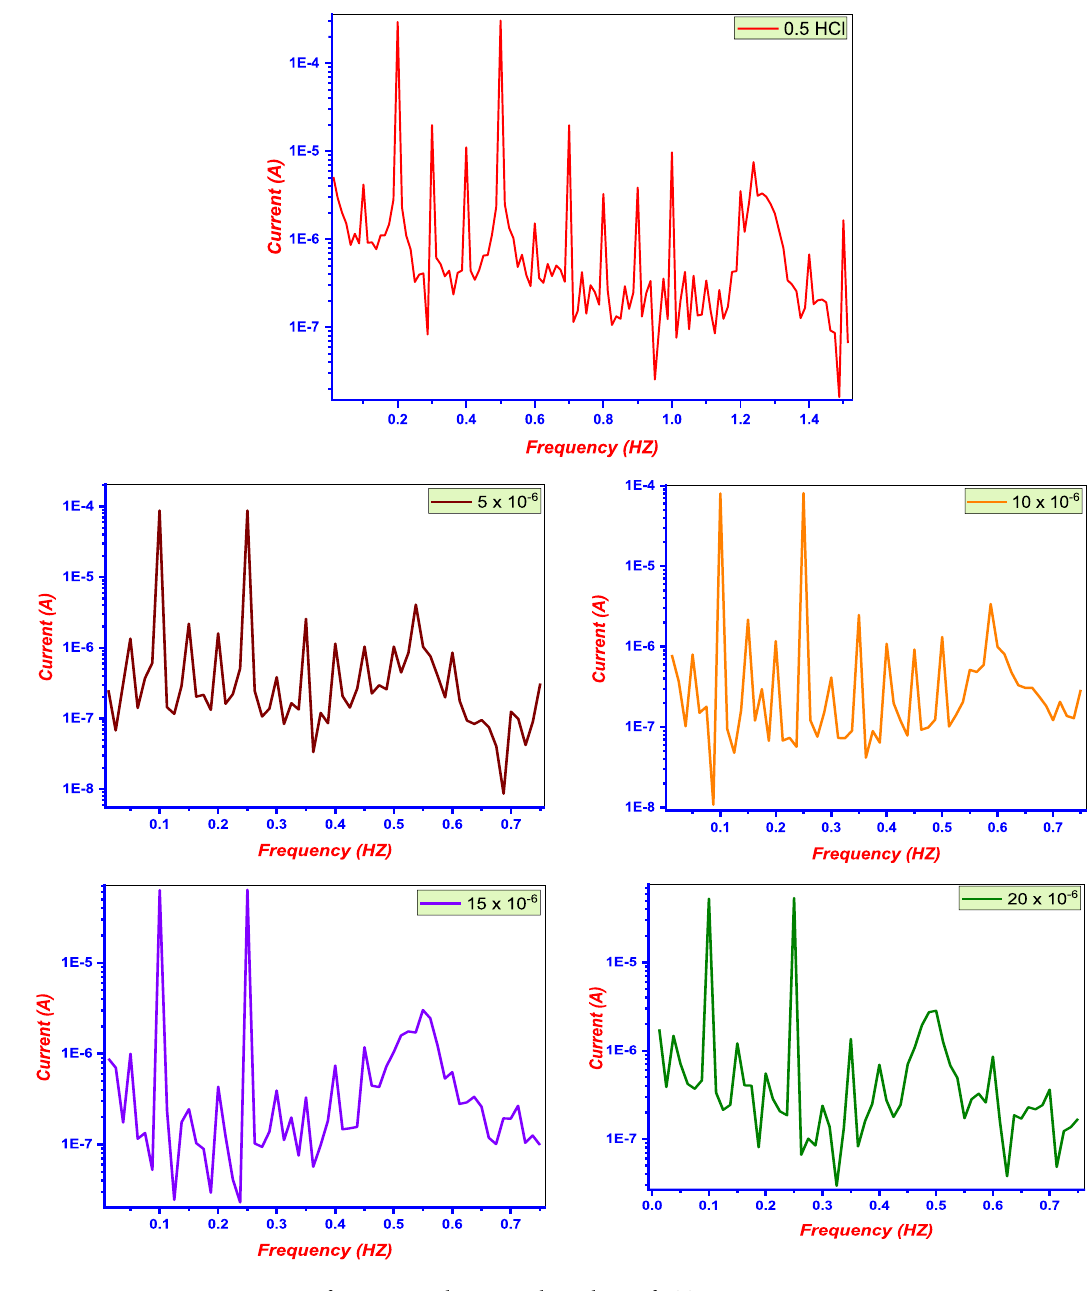
Figure 6. EFM spectra of Cu in test solutions with/ without of DTG .